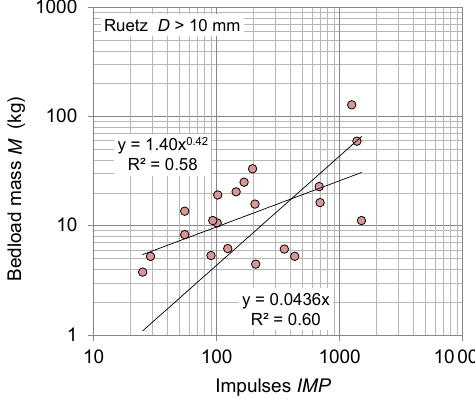
Figure 6. Ruetz: geophone calibration relationships for grains with D > 10mm between bedload mass M and number of impulses IMP.